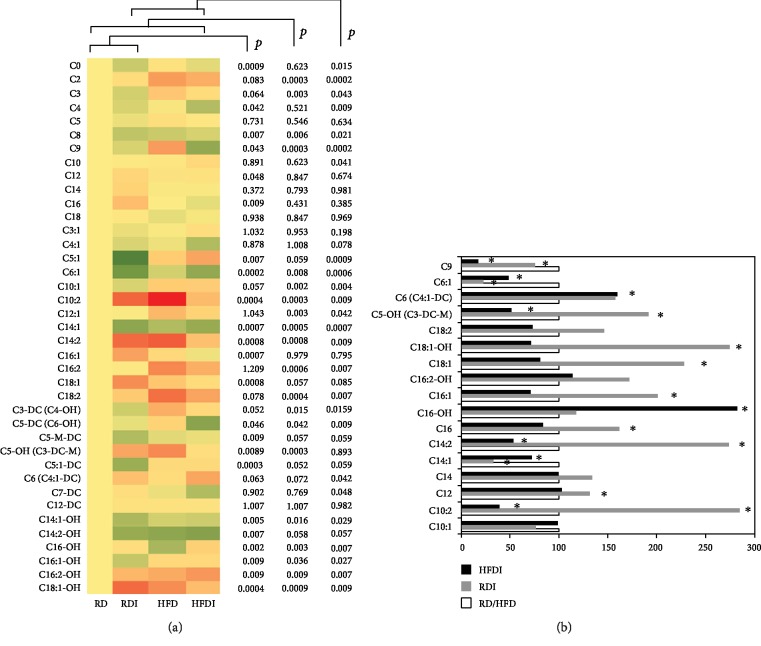
Comparison of acylcarnitine profiling between T. cruzi-infected and uninfected mice fed on different diets at 150 DPI. (a) Heat map representing the serum levels of various acylcarnitines during chronic infection in mice fed on either a RD or a HFD compared to uninfected RD mice at 150 DPI. Each row represents data for a specific metabolite, and each column represents the RD-fed uninfected (RD), RD-fed infected (RDI), HFD-fed uninfected (HFD), or HFD-fed infected (HFDI) mouse group. Different colors correspond to the different intensity level of metabolites (red > the control RD group and green < the control RD group). Statistically significant differences were tested using Student's t-test, and the corrected p values (q-value) are presented next to the heat map. Red, yellow, and green rectangles indicate high, moderate, and low expressions, respectively. (b) The percentage changes in the levels of acylcarnitines in infected mice compared to the respective diet-fed (RD and HFD) uninfected mice represented by a bar graph (∗significant change).